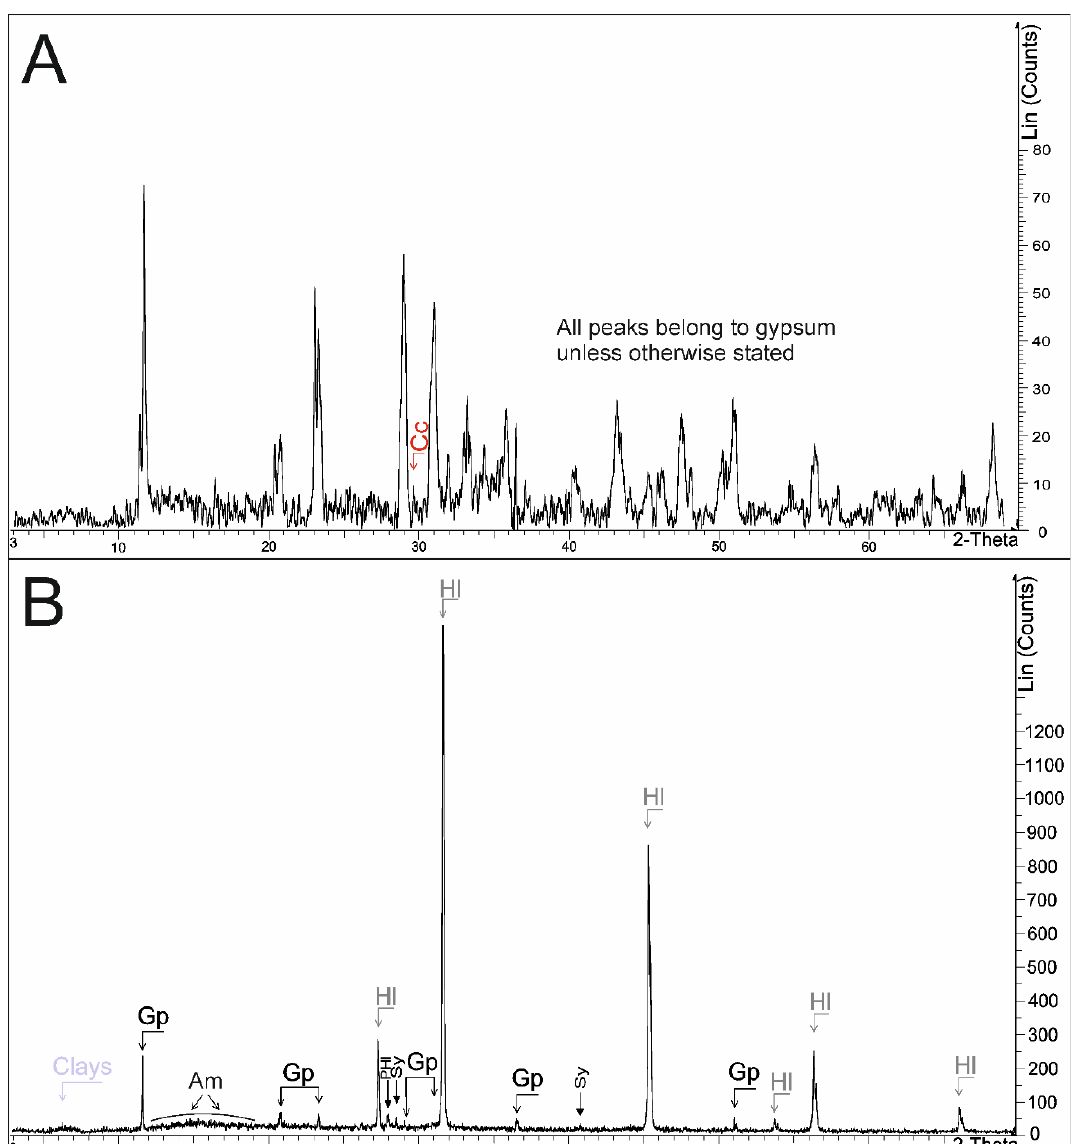
(Figure 7A). Sylvite (KCl) and polyhalite (K 2 Ca 2 Mg(SO 4 ) 4 · 2H 2 O) were only detected in PAJ incubations through XRD (Figure 7B). High halite content in diffractogram images and the detection of sylvite and polyhalite that were not observed in fixed SEM samples evidence that these phases precipitated from residual brine that were contained in microbial mats before the analysis. In addition, some protophases of phyllosilicates and amorphous phases were detected through XRD and SEM (Figure 7B).